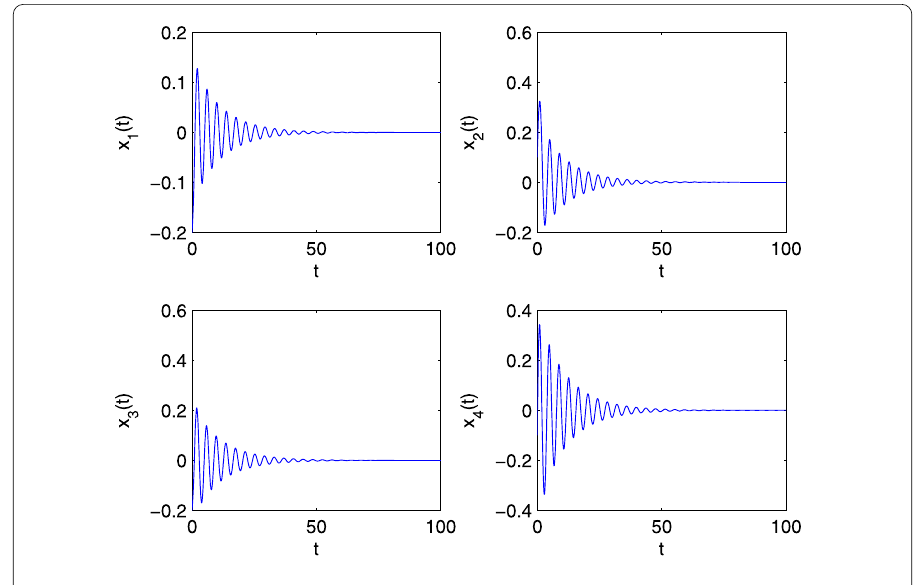
Figure 5 Time responses of system (5.2) with φ = 0.92, τ = 0.36 < τ ∗ 0 = 0.3976